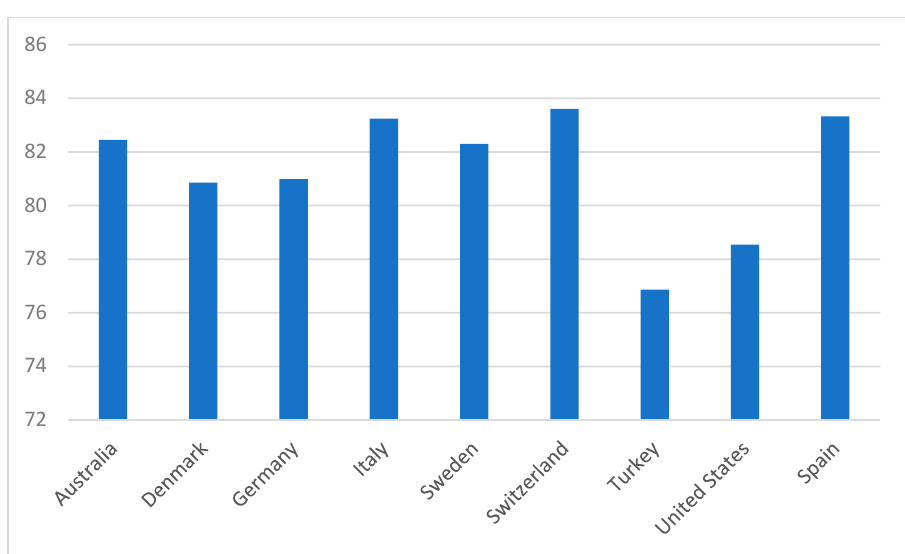
Figure 4. Life expectancy in 2016.